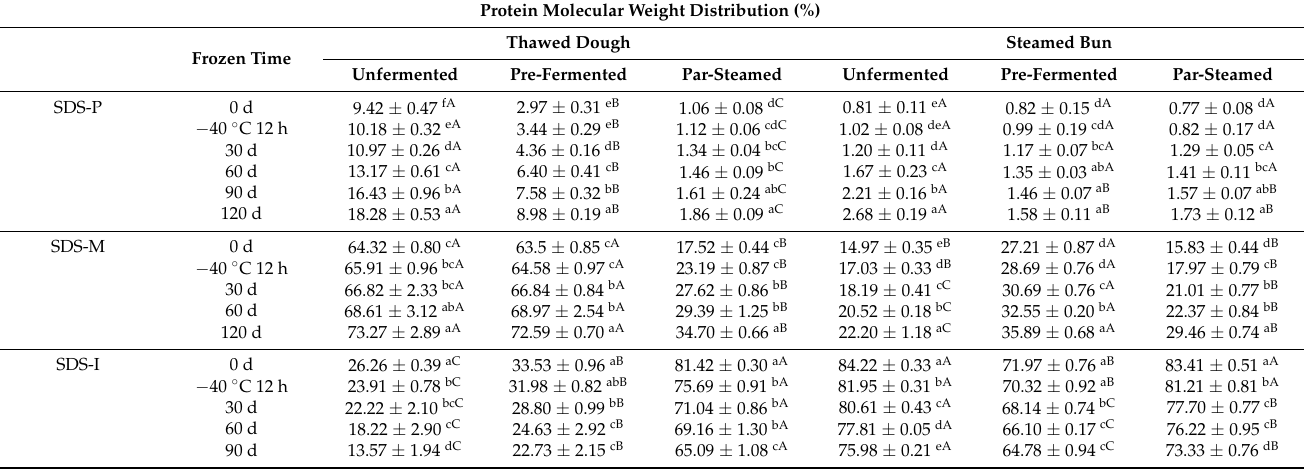
Data with different lowercase letters in the same column and capital letters in the same row for dough or bun indicate a significant difference ( p <